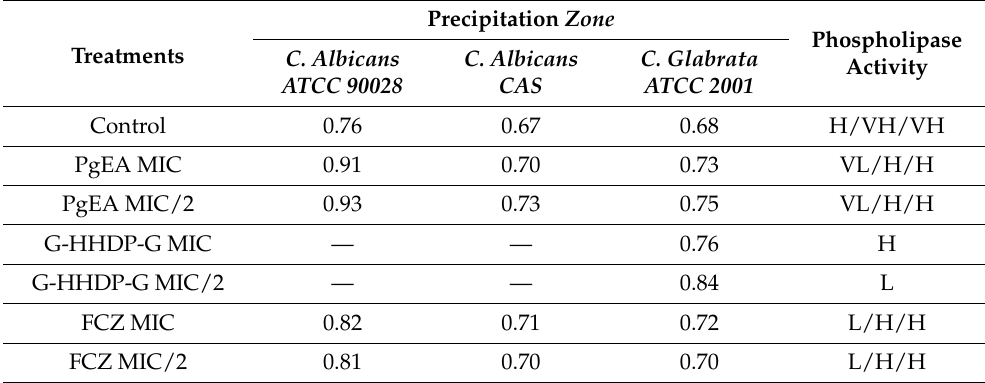
Figure 4. Time–kill curve for C. glabrata ATCC 2001 ( A ) and C. albicans ATCC 90028 ( B ). G-HHDP- G compound was tested at 3 × MIC. MIC: minimal inhibitory concentration. CFU: colony-forming unit. Time is expressed in hours. Negative control: no compound was added to the cell suspension.